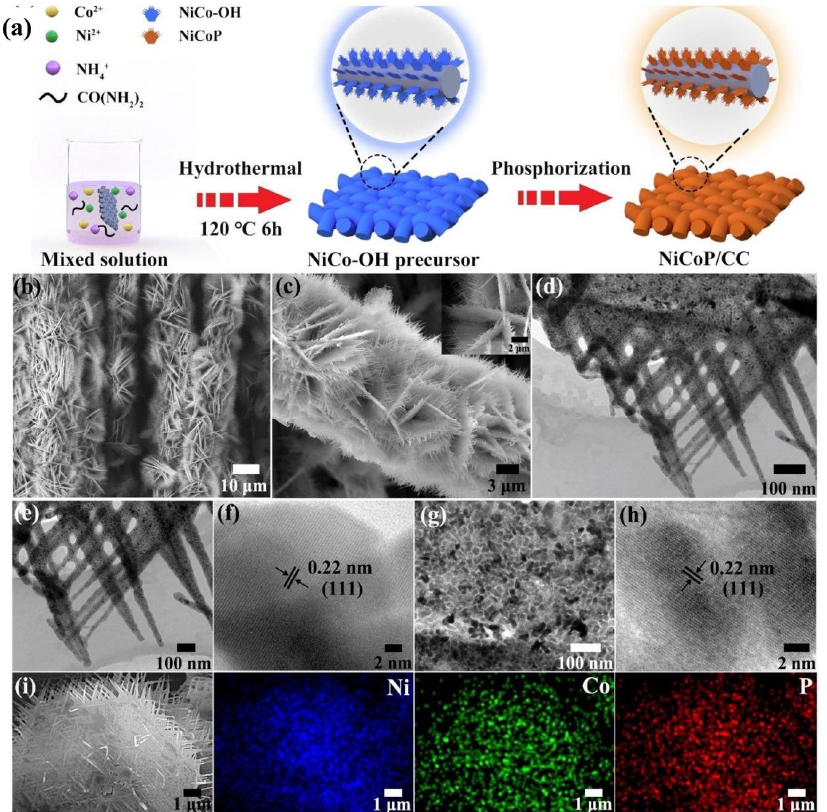
Figure 24. ( a ) Schematic illustration of the fabrication of NiCoP/CC; ( b ) low and ( c ) high-magnification SEM images; ( d , e , g ) TEM and ( f , h ) HRTEM images of the NiCoP/CC; and ( i ) SEM image and corresponding elemental mapping images of Ni, Co and P. Reprinted with permission from Ref. [103].